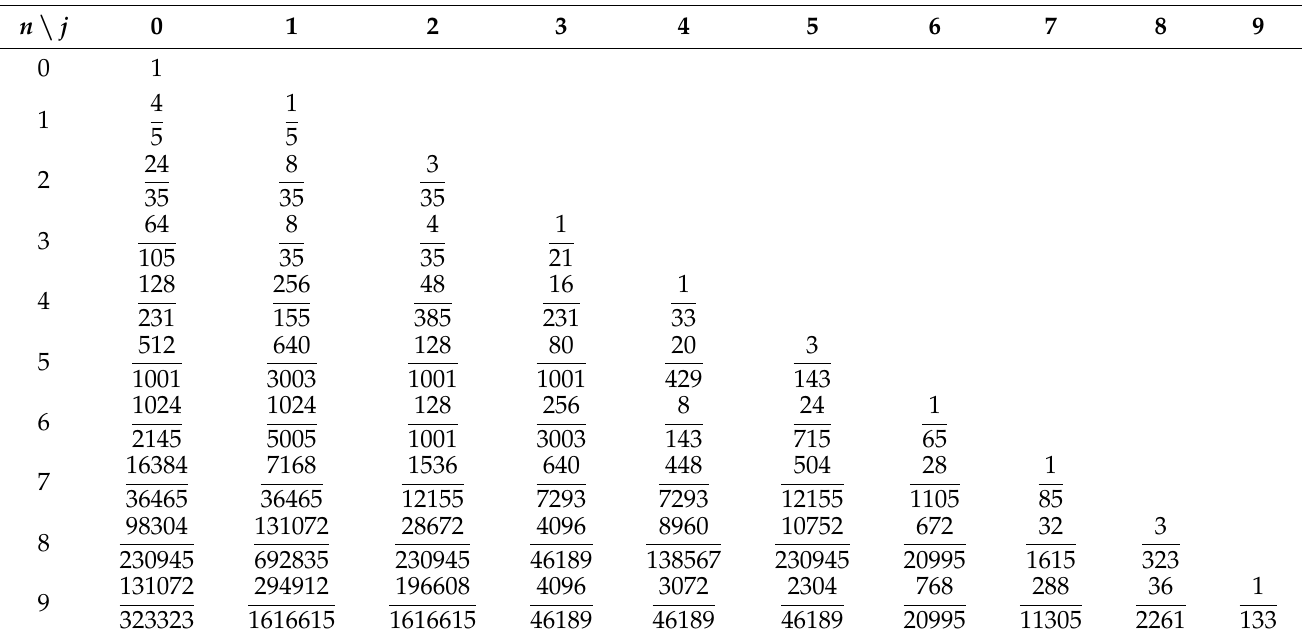
Table 1. Values of a n , j , α , β , α = 1/2, β = 2 and n , j = 0,1, · · ·